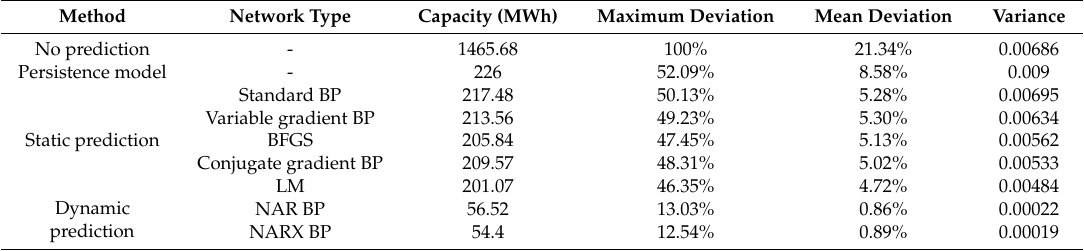
Table 1. Energy storage system (ESS) capacity based on different forecasting methods.